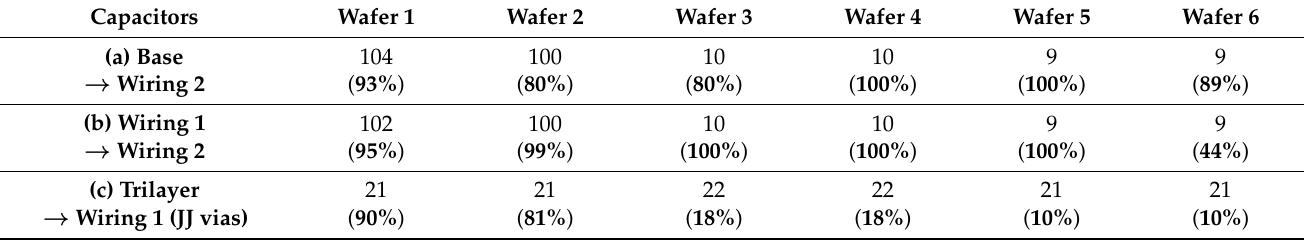
Table 2. Total number of investigated vias for 6 different wafers (corresponding to Figure 8) and yield for each type of via.